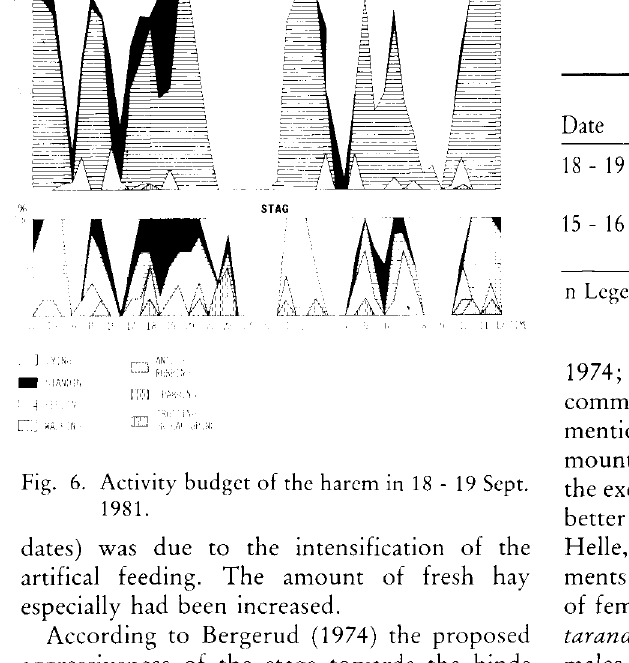
Table 1. Nocturnal and diurnal activity of dominant stag in sparring and presenting low-stretch